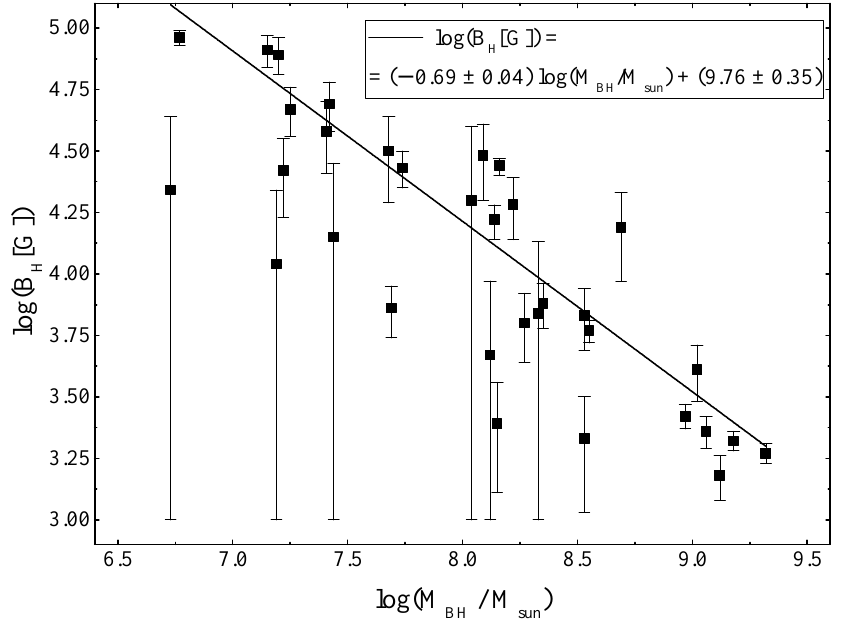
Figure 8. Dependence of the magnetic field intensity B H on the mass of the SMBH M BH